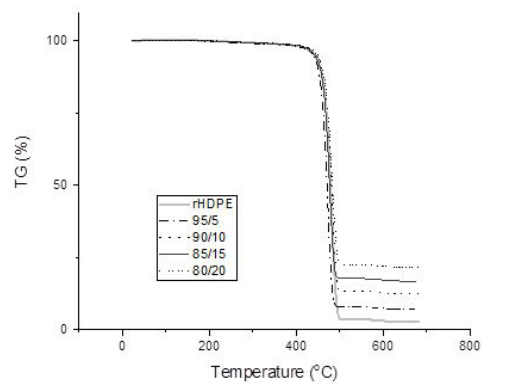
Figure 4. TG curves of rHDPE/mica formulations